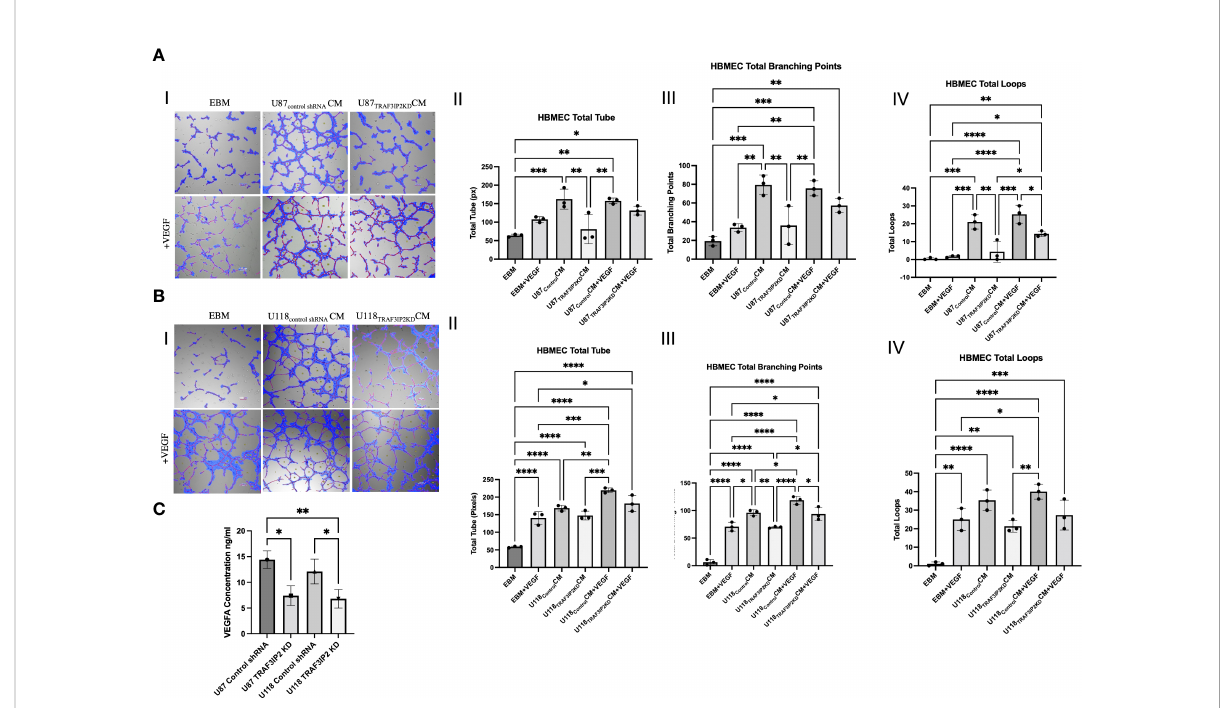
FIGURE 3 Tube formation assays demonstrating that knockdown of TRAF3IP2 in GBM reduces angiogenesis. HBMEC (human brain microvascular endothelial cells) were cultured in the following conditions: normal media (EBM), conditioned media (CM) from U87 Control shRNA or U118 Control shRNA cells, or CM from U87 TRAF3IP2KD or U118 TRAF3IP2KD cells (Figure 3AI, 3BI). The addition of exogenous VEGF at a concentration of 40 ng/ml was also performed (bottom rows, AI and 3BI). Effects of CM from U87 TRAF3IP2KD (A) or U118 TRAF3IP2KD (B) with or without VEGF on angiogenesis parameters including total tube [measured in pixels (px)], total branching points, and total loops are shown (I-IV). U87 TRAF3IP2KD and U118 TRAF3IP2KD compared to U87 Control shRNA and U118 Control shRNA secreted signi fi cantly lower amounts VEGF in the medium by enzyme-linked immunosorbent assay (ELISA) (C) . Signi fi cance was calculated by ANOVA: *p < 0.05, **p < 0.01, ***p < 0.001, ****p <